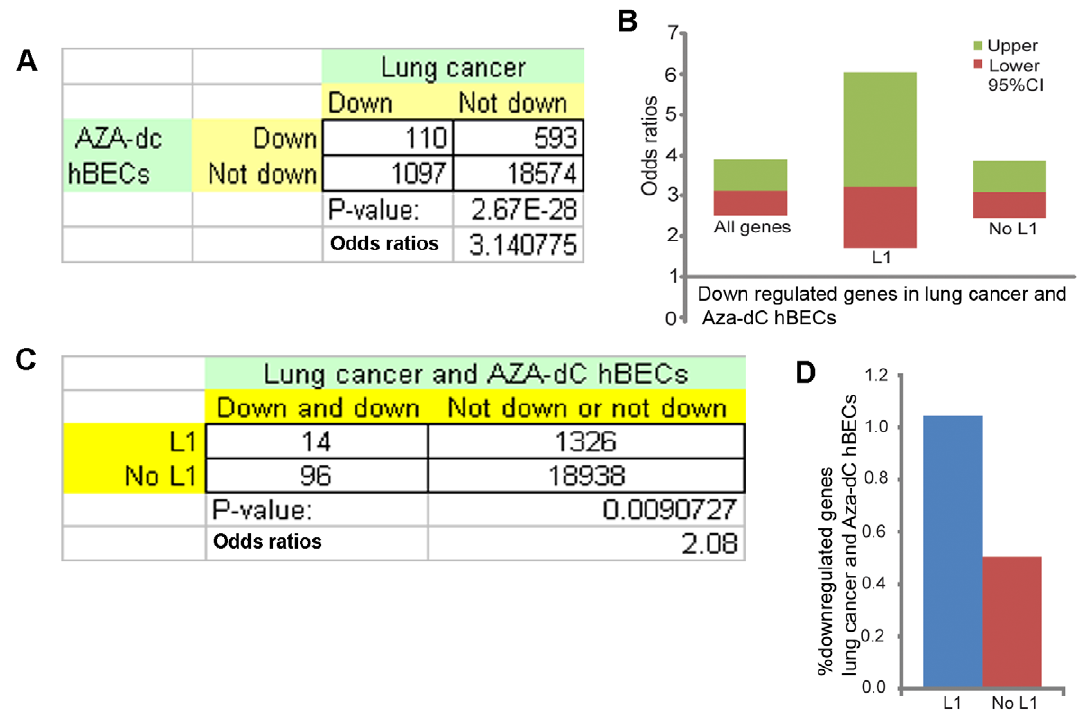
Figure 3. Demethylated genome and hypomethylated intragenic L1s repress gene expression in cancer. A) 2 6 2 tables, p values and odds ratios and B) odds ratio for mRNAs that are under-expressed (‘‘Down’’) in lung cancer and Aza-dC-treated hBEC cells compared to non-Aza-dC- treated hBEC cells for (A and B) all genes, (B) genes with L1s (L1) and genes without L1s (No L1). B) The middle, top and bottom lines of each two- color box are the odds ratio and upper and lower 95% confidence interval (CI), respectively. C) 2 6 2 tables, p values and odds ratios and D) percentages of mRNAs that are under-expressed (‘‘Down’’) in both Aza-dC-treated cells and cancer cells compared with genes that are not downregulated in Aza-dC-treated cells or cancer, for genes with and without L1s (L1 and No L1). The corresponding 2 6 2 contingency tables for A) and B), and C) and D) are provided in Supporting Tables S4, and S5, respectively.